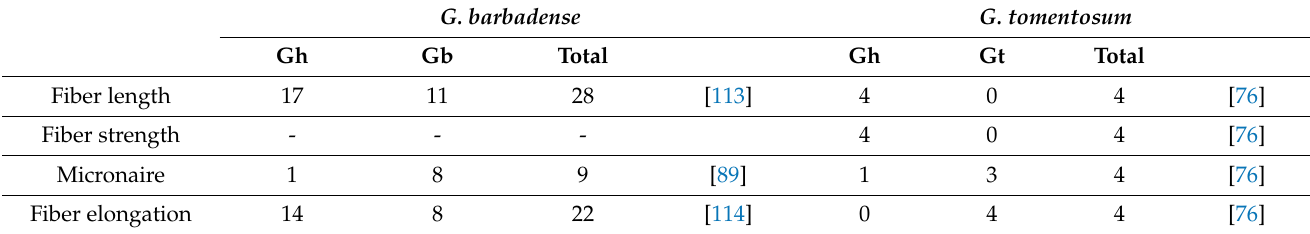
Table 2. Summary of QTL mapped in interspecific Gossypium